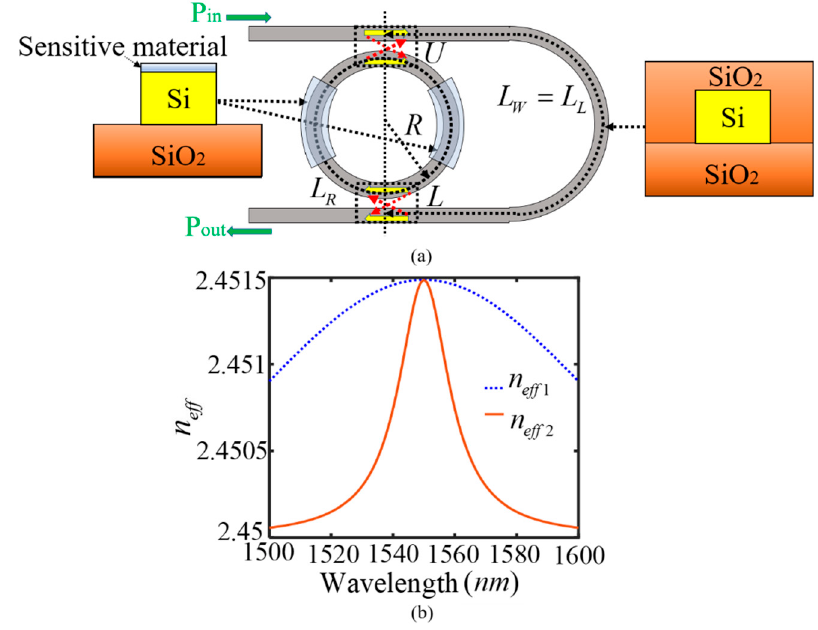
Figure 3. The designed two-parameter SIMRR sensor. ( a ) Structural diagram of the designed two- parameter SIMRR sensor. The surfaces of two half-ring waveguides in the left and right are separately coated by two sensitive materials to detect two kinds of gases. ( b ) when two gases to be detected are only exposed to two half-ring waveguides in the left and right, it is assumed that their effective refractive index changes are the Gaussian and Lorentz functions of wavelength, respectively. At C1 = C2 = 5%, their waveguide effective refractive indices can be separately given by n eff1 = n eff + ∆ n eff1 and n eff2 = n eff + ∆ n eff2 .